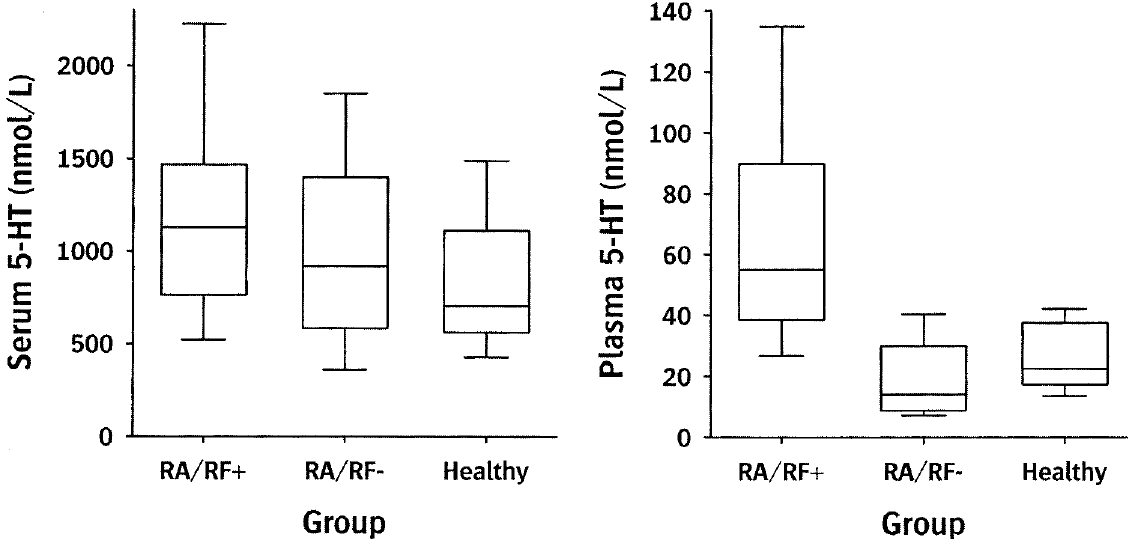
FIG. 1. Box plot showing serum and plasma levels of 5-HT in 33 patients with seropositive rheumatoid arthritis (RA/RF+), 28 patients with seronegative RA (RA/RF–) and 26 healthy individuals. The seropositive patients had higher serum and plasma levels of 5-HT than the healthy individuals ( p = 0.044 and p < 0.001,